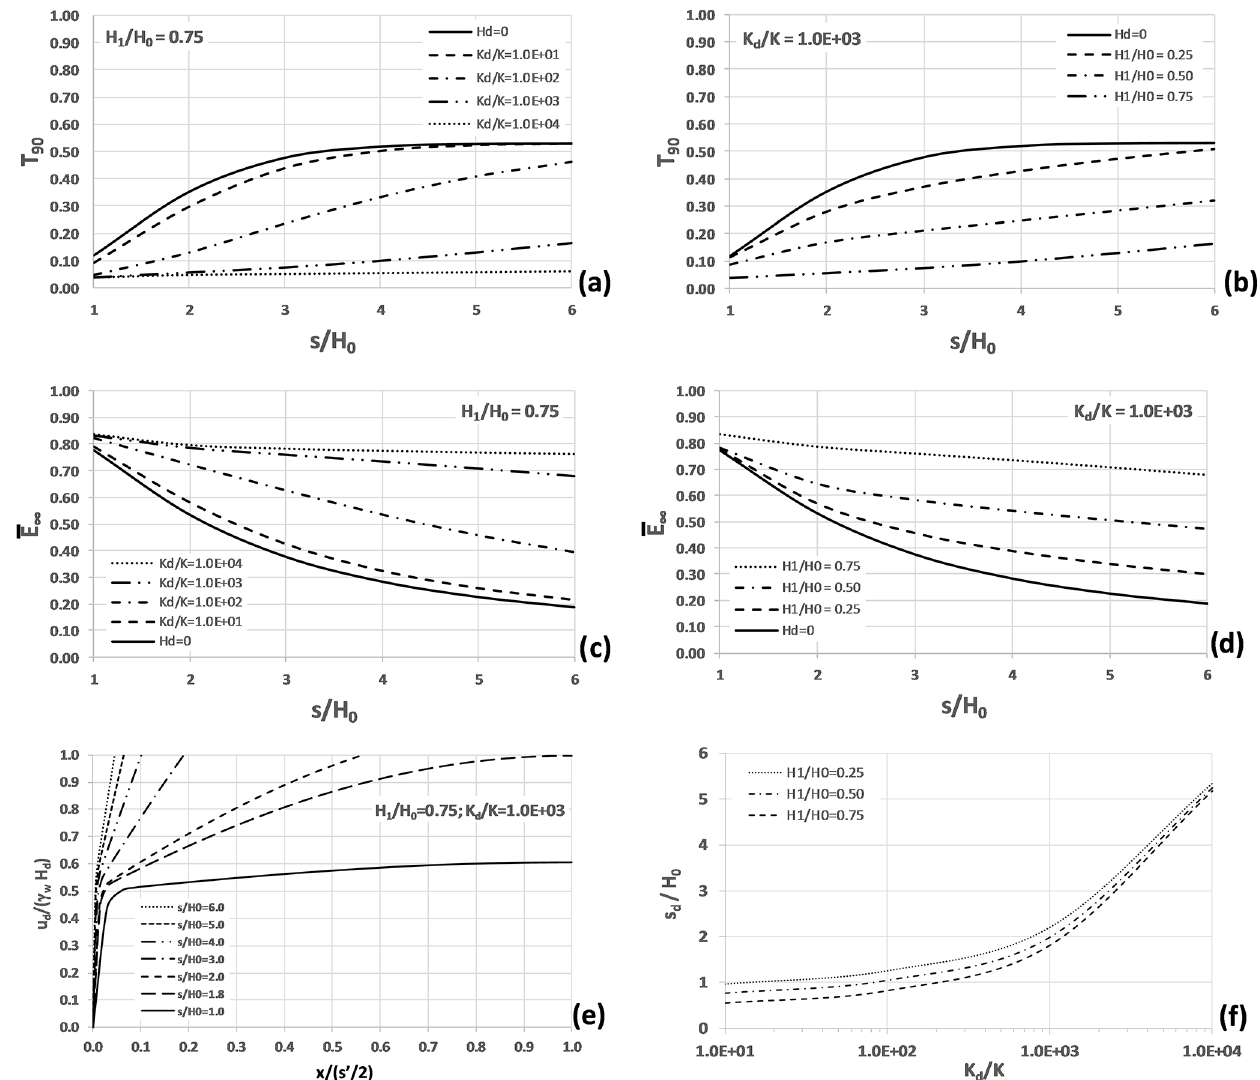
Figure 2. Results of the FEM analyses (assuming H = H 0 ). Dimensionless time, T 90 , as a function of trench spacing and of (a) K d /K ratio for H 1 /H 0 = 0 . 75 and (b) H 1 /H 0 ratio for K d /K = 1000. Average steady-state efficiency as a function of trench spacing and (c) K d /K ratio for H 1 /H 0 = 0 . 75 and (d) H 1 /H 0 ratio for K d /K = 1000. (e) Dimensionless pore pressure over the lowermost boundary of layer d , u d /(γ w H d ) , as a function of x/(s (cid:48) / 2 ) and s/H 0 , for K d /K = 1000 and H 1 /H 0 = 0 . 75. (f) Values of s d /H 0 as a function of K d /K and H 1 /H 0